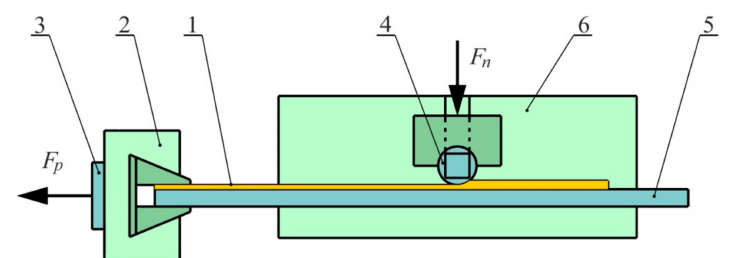
Figure 12. Schematic representation of the SRT: 1—specimen, 2—jaws, 3—piezoelectric transducer, 4—tool pin, 5—supporting plate, 6—vertical guide; prepared on the basis of